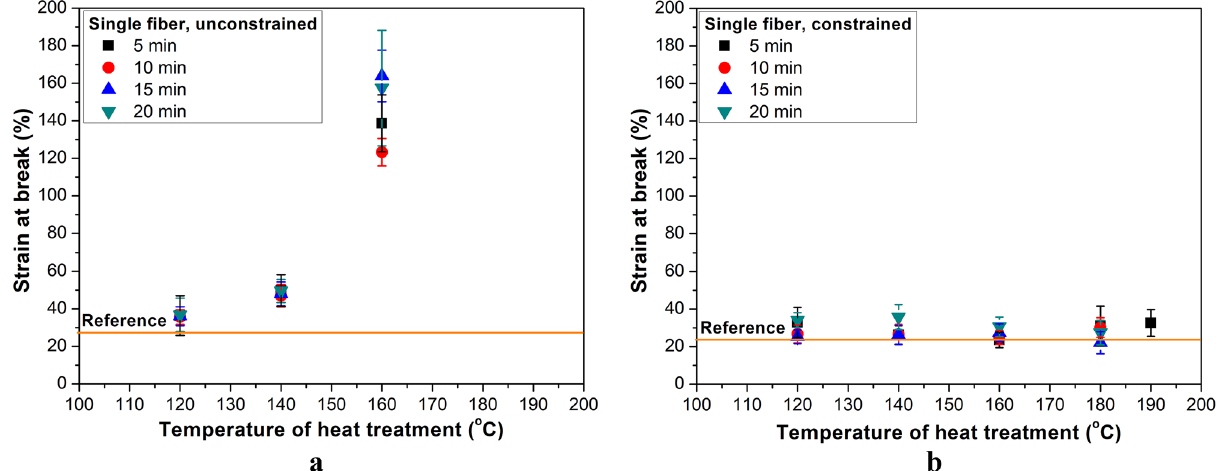
Figure 7. Strain at break of single fibers as a function of heat treatment temperature for different treatment times: in the case of free ( a ) and constrained ( b ) treatment.